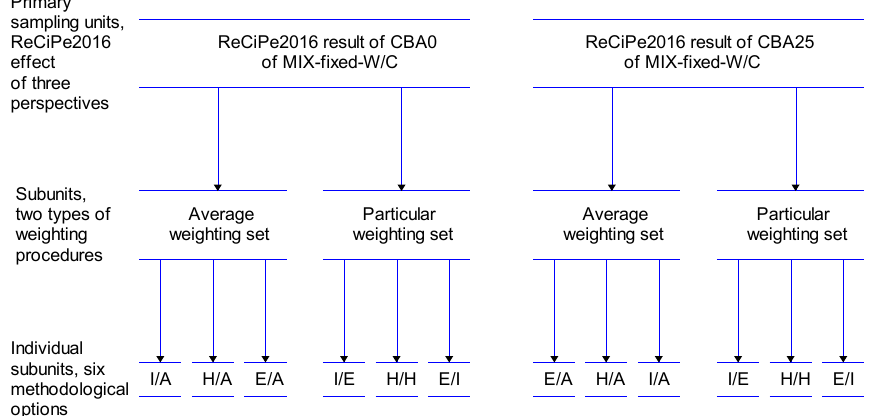
Figure 2. Design structure of a two-stage nested hierarchical system for conducting the environmental evaluation of the mixture with a fixed water / cement ratio (MIX-fixed-W / C) alternatives: CBA0 vs. CBA20 (note: individualist / average [I / A], hierarchicst / average [H / A], egalitarian / average [E / A], individualist / individualist [I / I] hierarchist / hierarchist [H / H], and egalitarian / egalitarian [E / E] are the methodological options of the ReCiPe2016 single score results).